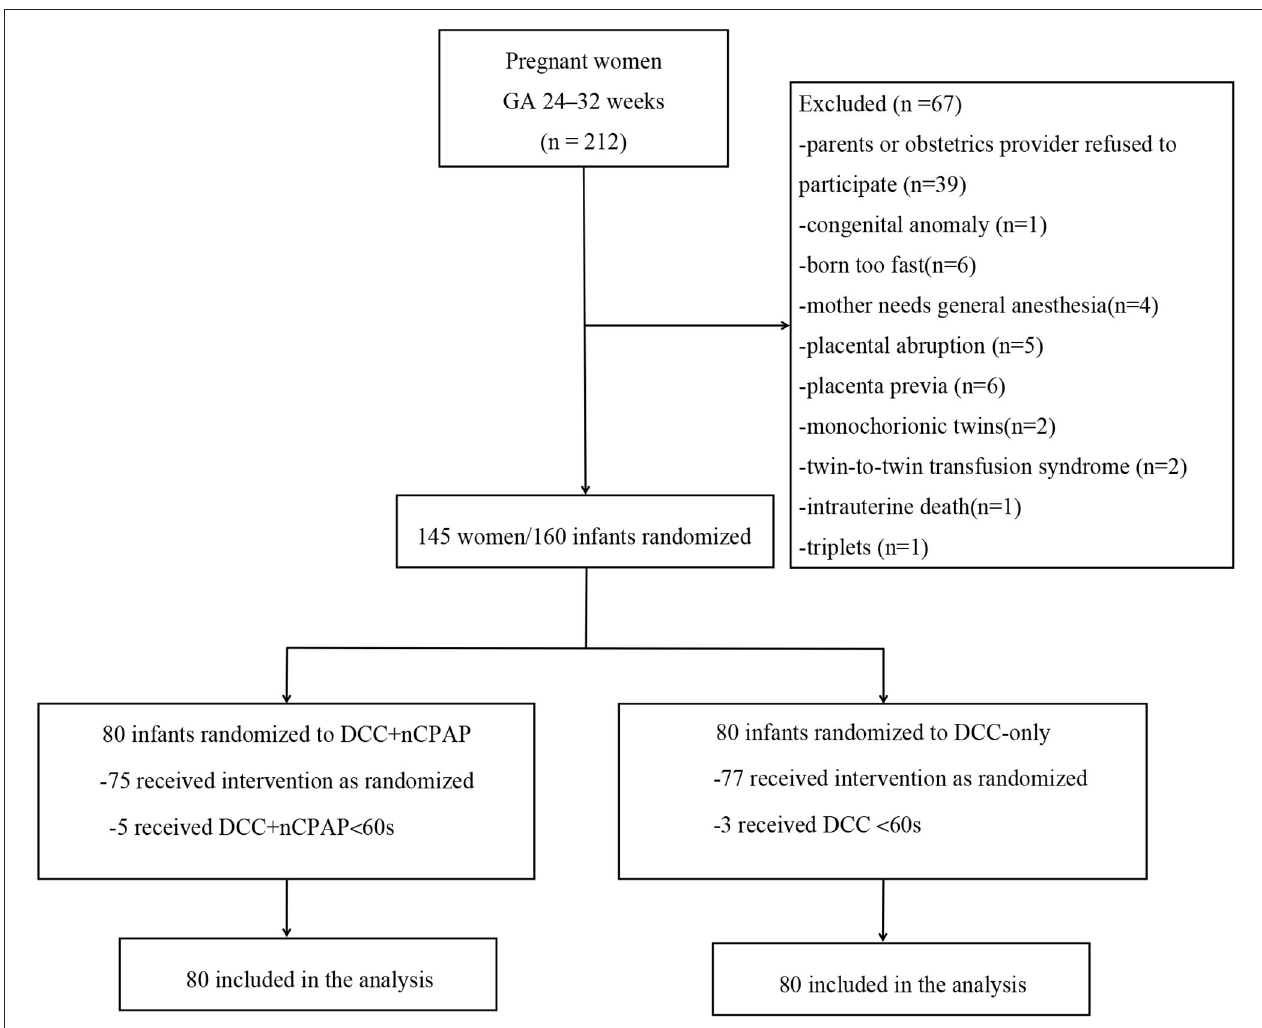
FIGURE 1 | Flow diagram of patients in the study.